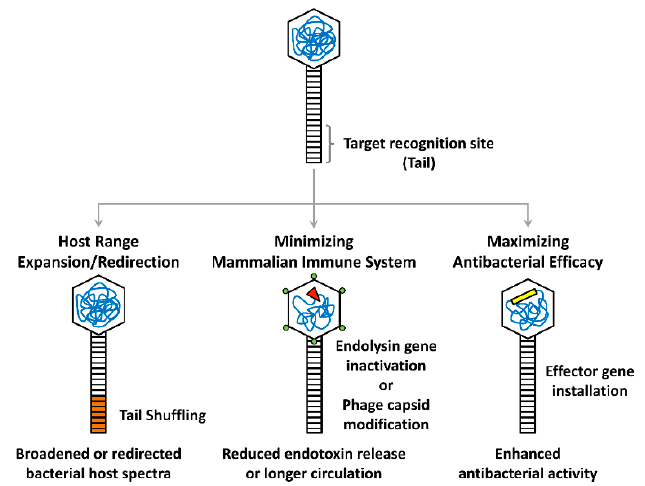
Figure 1. Synthetic phage engineering strategies. Major strategies for modifying the target recognition site (tail), phage head (hexagonal), or genome (tangled lines) are depicted. The bacterial host spectrum of a phage can be expanded or redirected by tail shuffling (orange), while mammalian host immune responses can be reduced or minimized by insertional inactivation of the endolysin gene (red triangle) or capsid modification (green circles). Heterologous effector genes (yellow rectangle) can also be installed on the phage genome to maximize the antibacterial efficacy.